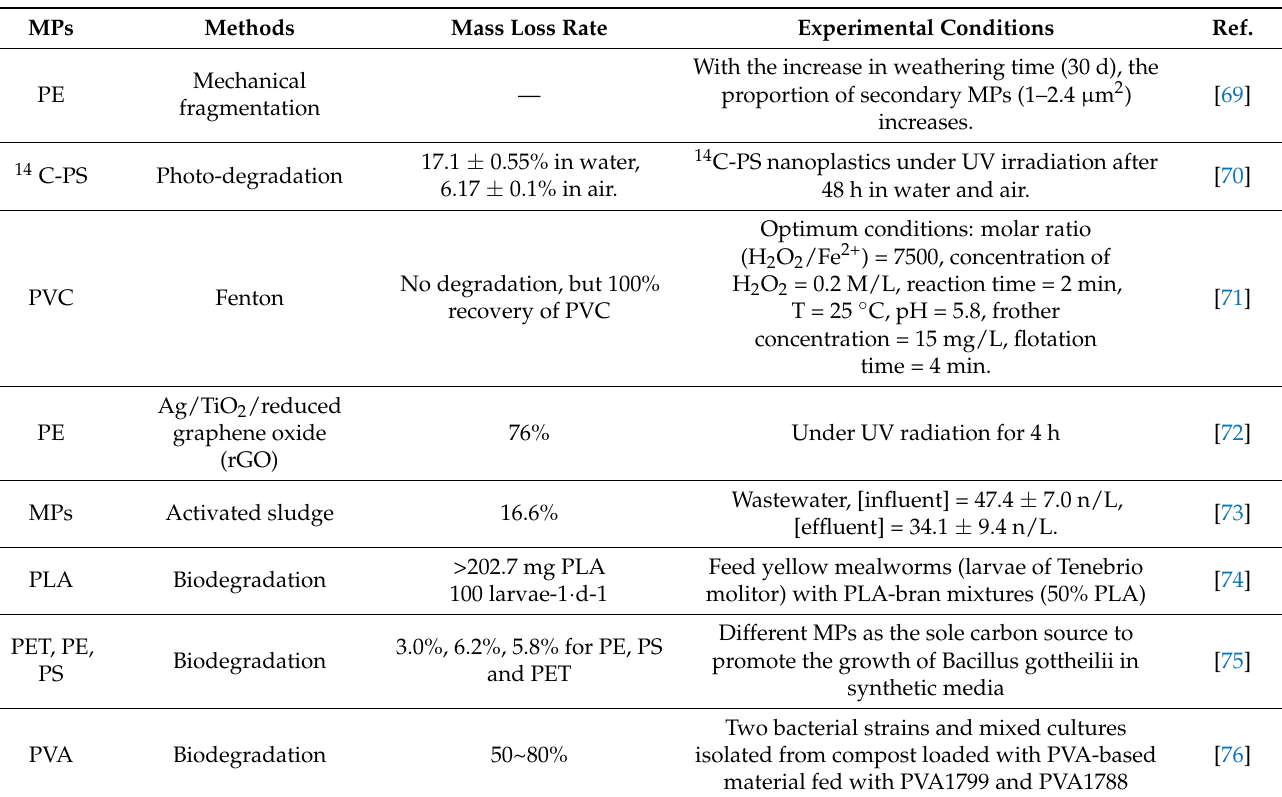
Table 2. Recent studies of microplastic aging using different